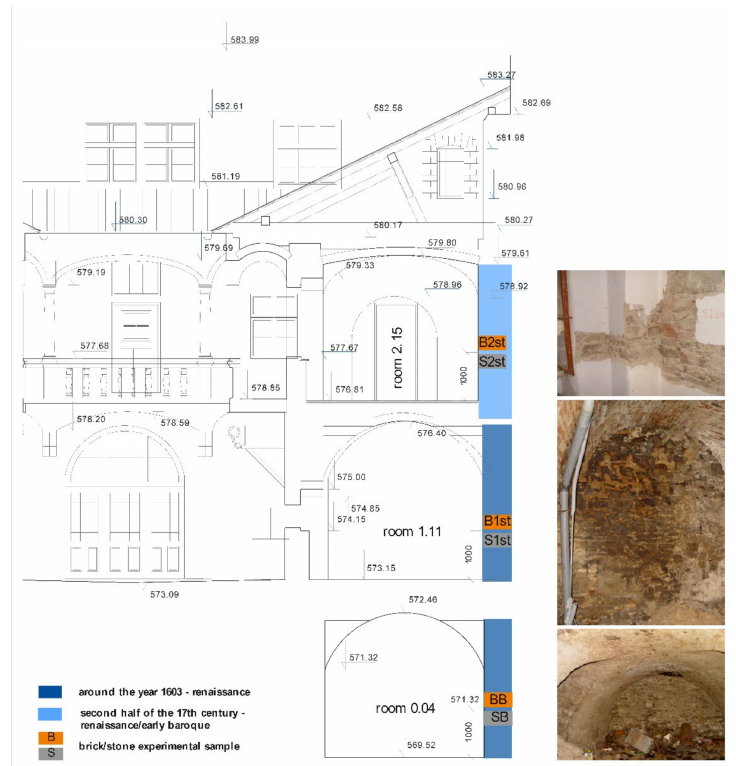
Figure 5. Location of the sampling points in the